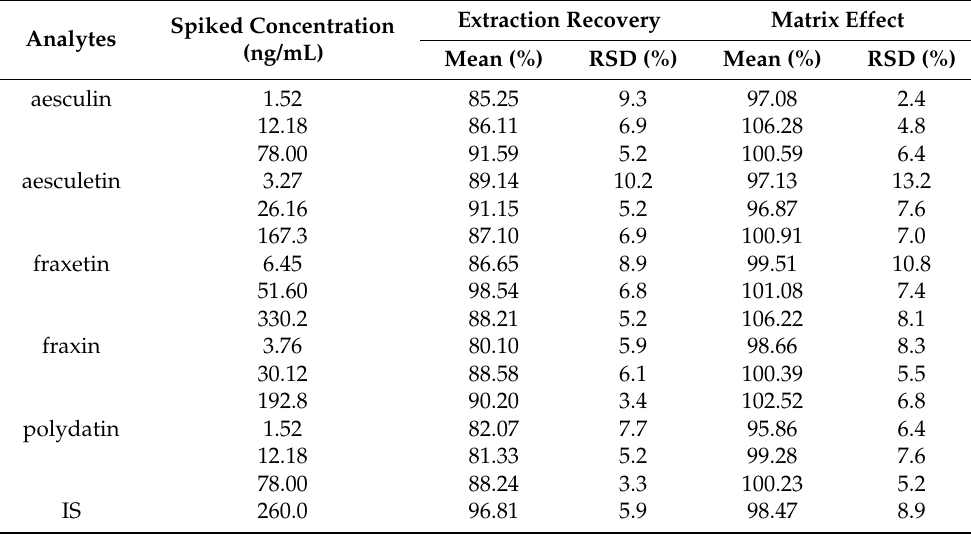
Table 4. Extraction recovery and matrix effect of analytes in beagle dog plasma (n = 6).